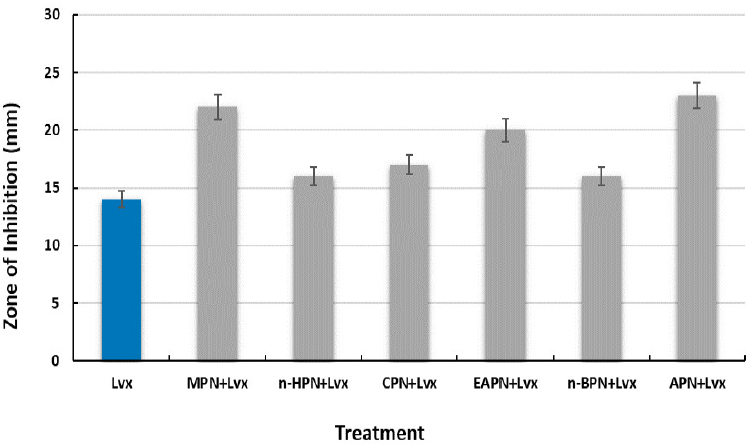
Figure 5. Antibiotic reversal activity of P. nigrum extracts in combination with levofloxacin ( 5 μg) for S. aureus.